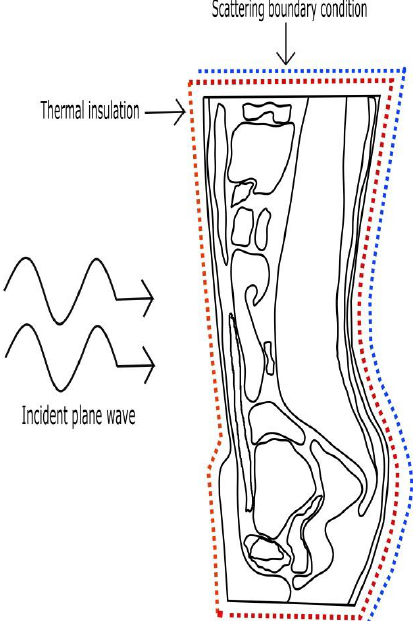
Figure 2: Boundary conditions for numerical analysis